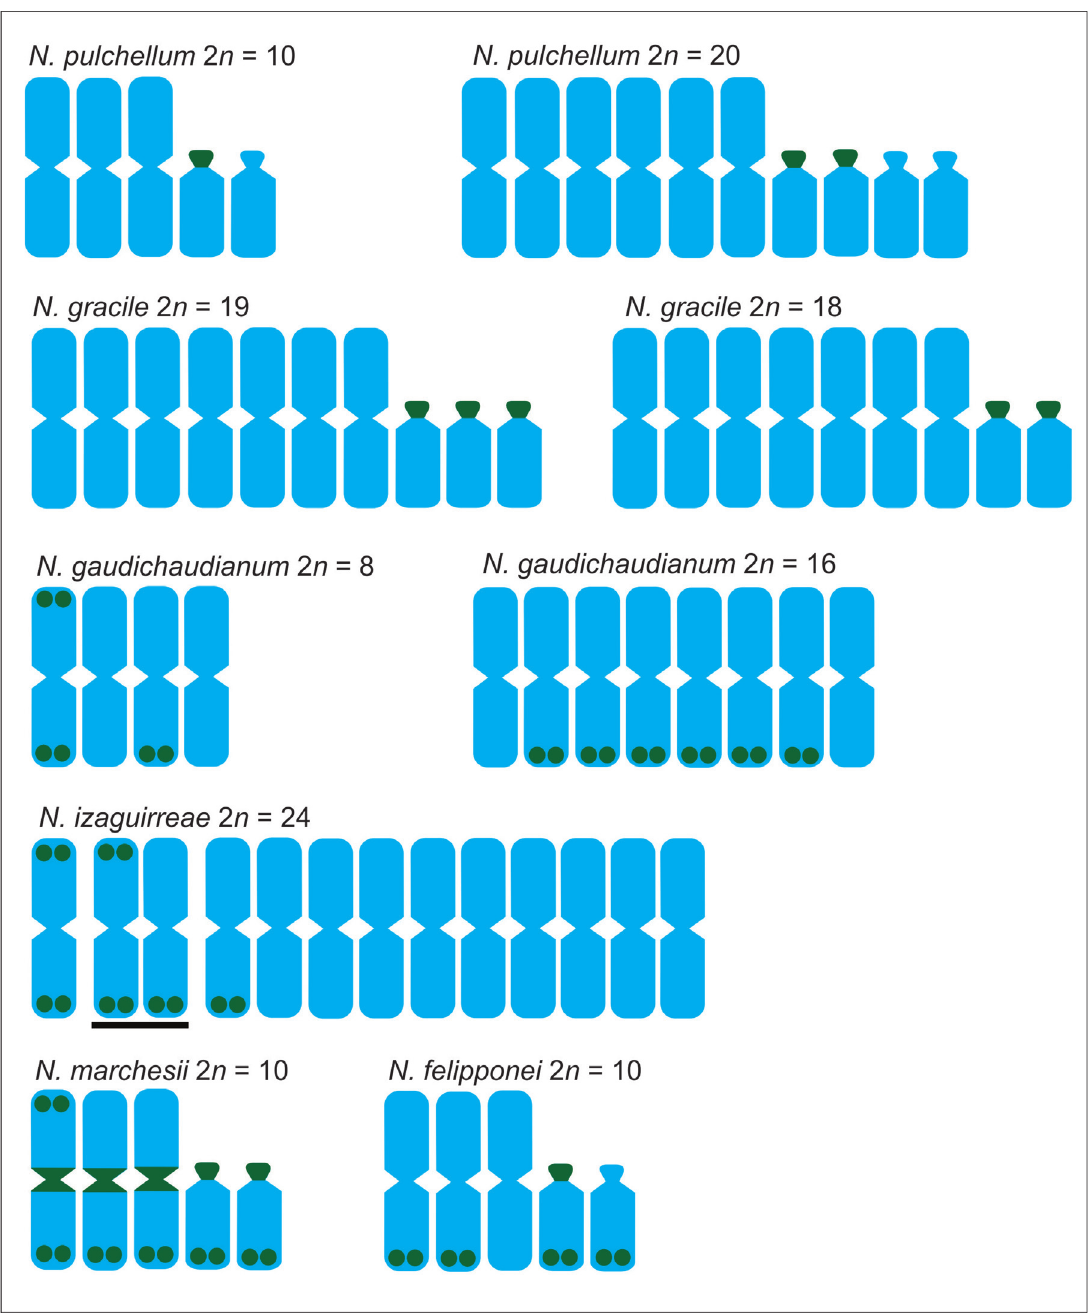
Figure1 -Graphicrepresentationshowingthedistributionof35SrDNAsites(green)intheanalyzedspeciesofthegenus Nothoscordum (basedonSouza et al. , 2012). Bar in Nothoscordum izaguirreae indicates heteromorphic chromosome